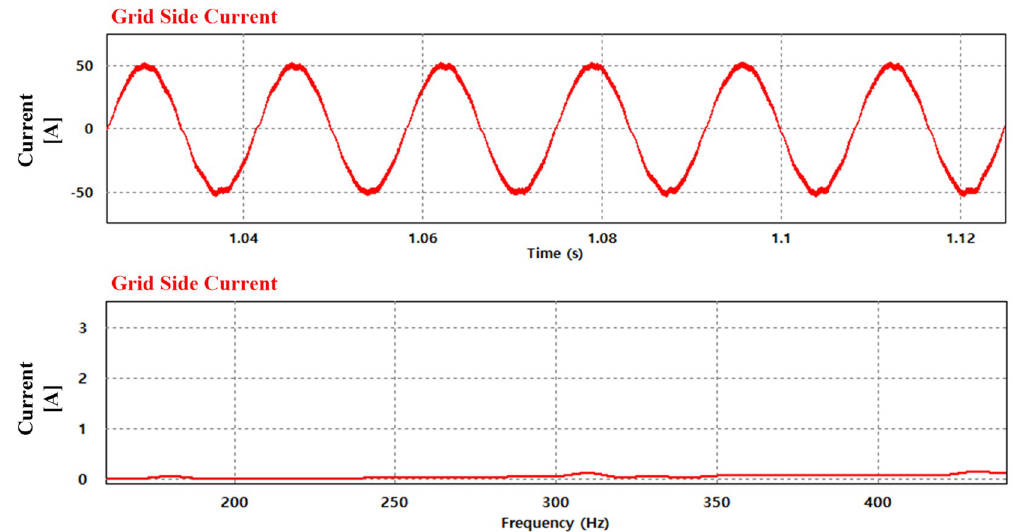
Figure 11. Simulation results when applying lower-order harmonics compensation method.